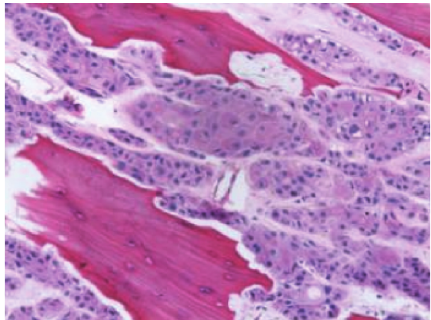
Figure 2: Low magnification (20x) hematoxylin and eosin patho- logical photomicrograph showing squamous cell carcinoma invad- ing into ossified